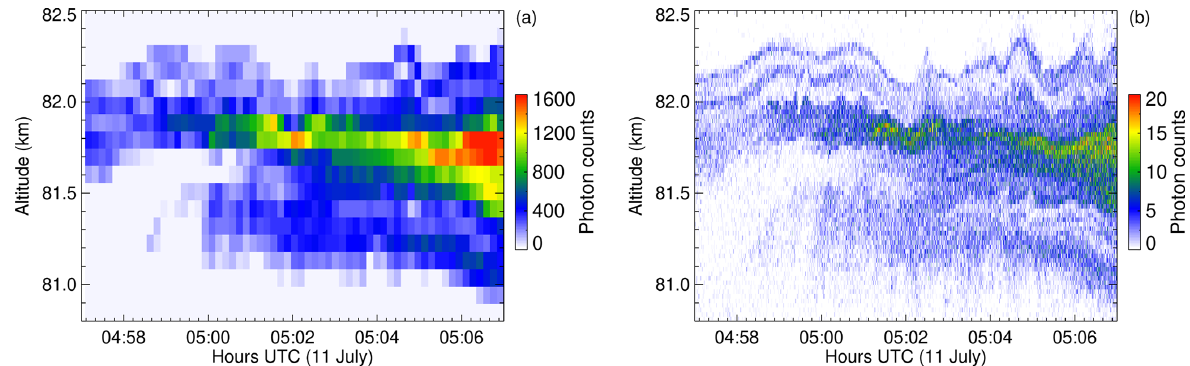
Figure 8. Photon counts of a 10min section of the data shown in Fig. 7c with (a) 10s × 100m resolution and (b) 0.3s × 25m resolution.